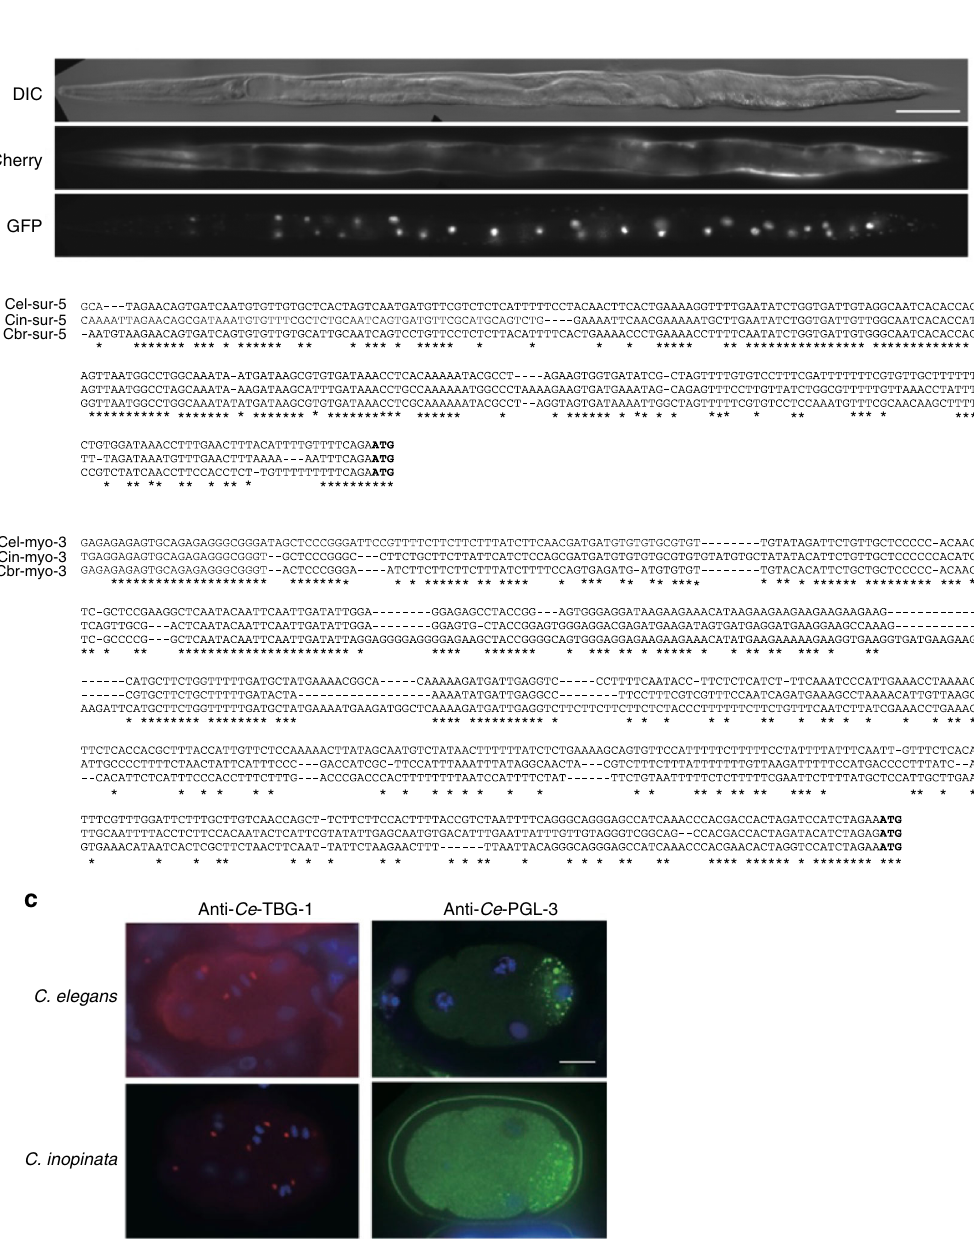
Fig. 3 Conservation of regulatory sequences and amino acid sequences between C. elegans and C. inopinata . a Transgenesis in C. inopinata using C. elegans - derived transgene. Ce-MYO-3::mCherry (body wall muscle: bottom) and Ce-SUR-5::GFP (somatic nuclei: bottom) signals in an adult female animal are shown. Scale bar: 100 μ m. b Comparison of promoter regions of the sur-5 and myo-3 gene. c Immuno fl uorescence using antibodies against C. elegans proteins. Anti-Ce-TBG-1 (red) stains centrosomes, and anti-Ce-PGL-3 (green) stains P granules (germ granules) in both C. elegans and C. inopinata embryos. Blue: DAPI. Scale bar: 10 μ